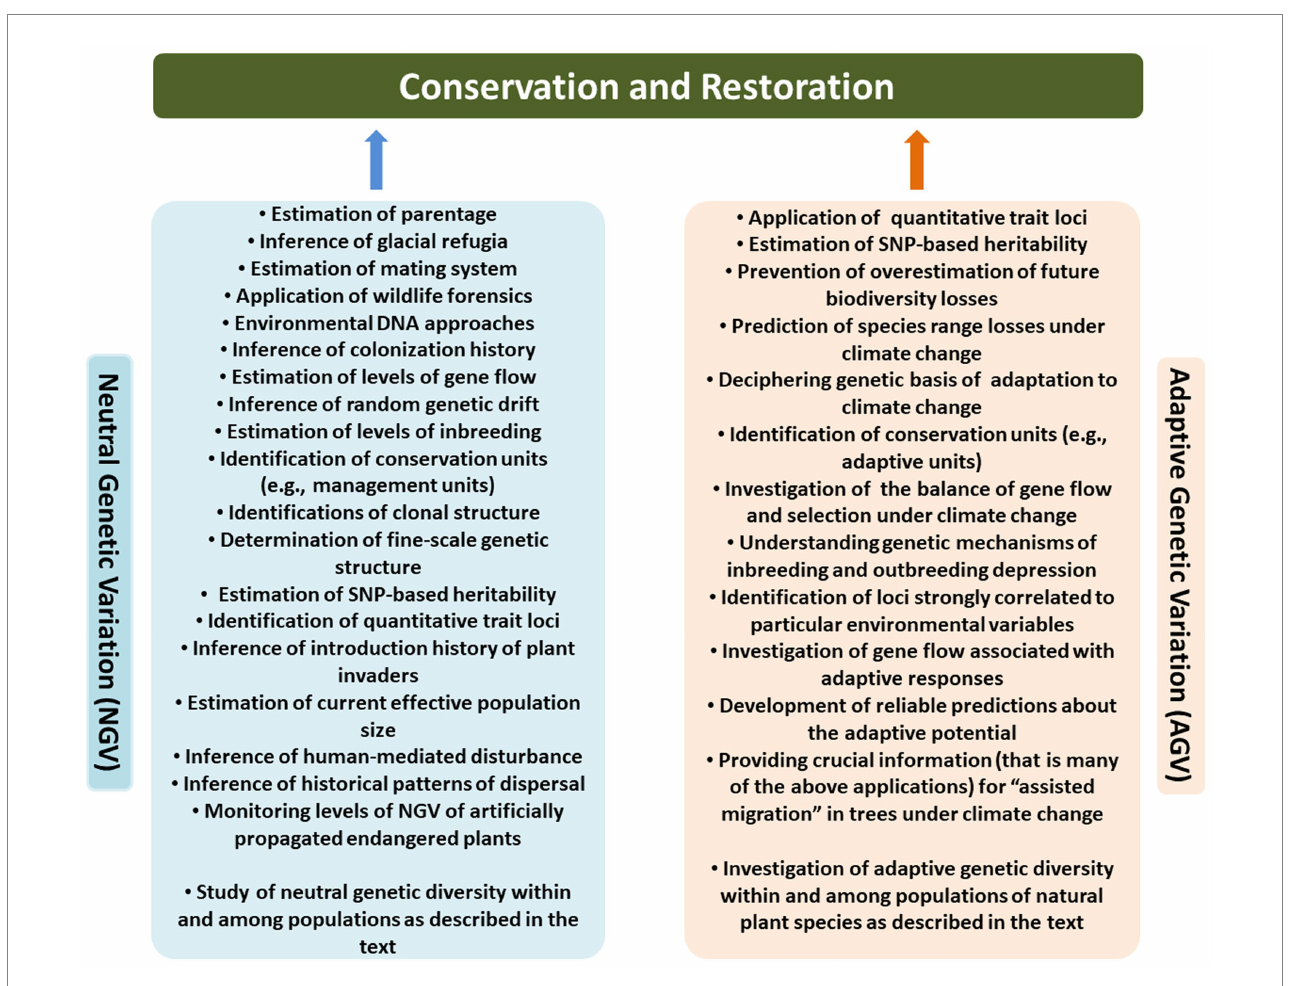
FIGURE 1 Summary of applications of neutral (NGV, left; in this review, we consider NGV as population genetic analyses using neutral markers) and adaptive genetic variation (AGV, right) to develop conservation and restoration